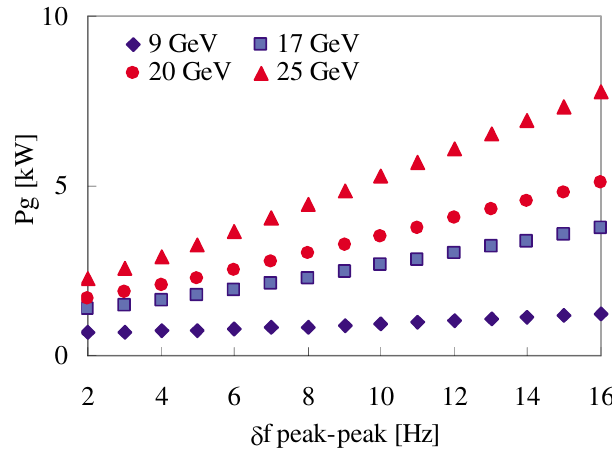
FIG. 14. (Color) Generator power needed to operate 18-cell SST for four final beam energies versus peak-to-peak